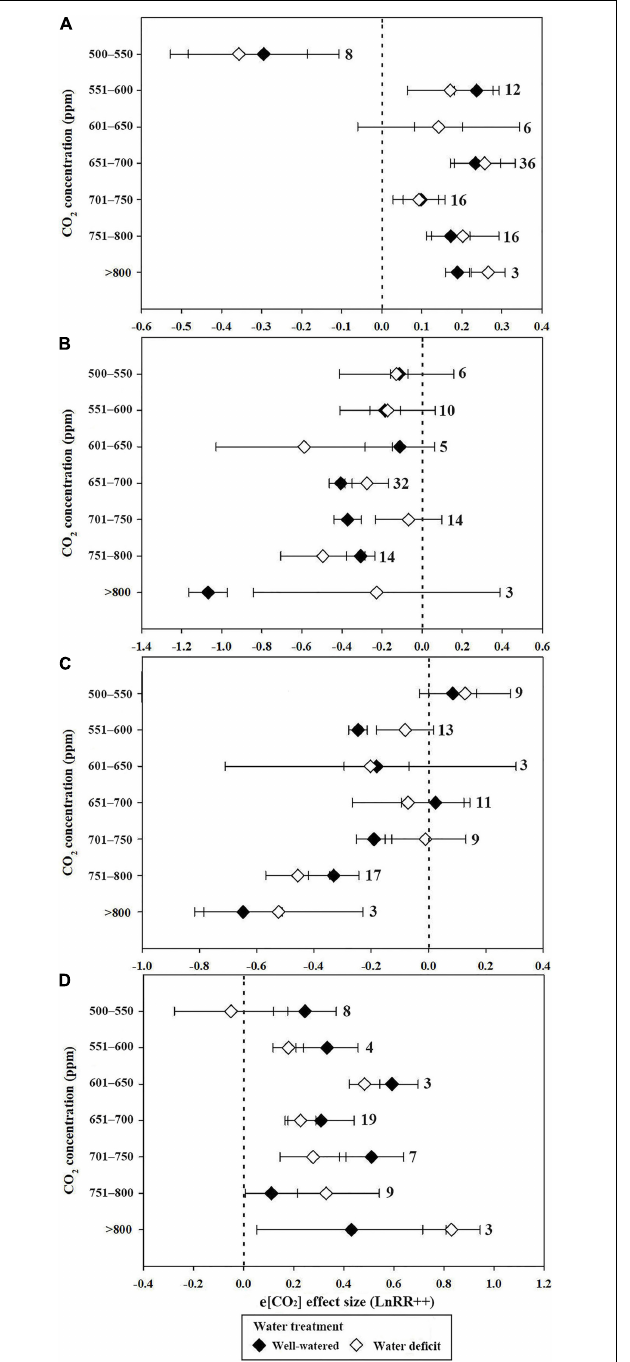
FIGURE 3 | Mean effect sizes of water deficit on P n (A) , G s (B) , T r (C) , and WUE (D) under a[CO 2 ] (black circles) and e[CO 2 ] (white circles) treatment. Water-deficit treatments were based on three types of FWC: 65–55, 54–40, and < 40%.